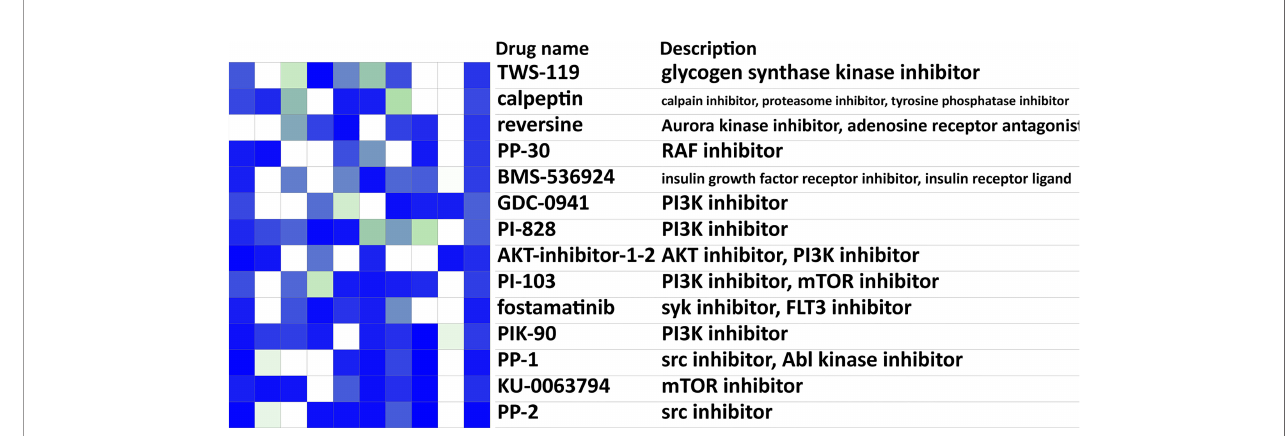
FIGURE 6 | Drug prediction analysis for targeting lung metastasis. Heatmap of the top 20 possible CMAP drugs that could reverse the breast cancer lung metastasis signature. The scores of 20 drugs ’ effects on 9 cell lines, drugs names, and their descriptions were shown. Negative scores (blue in the heatmap) indicated an ability for a given drug to reverse the breast cancer lung metastasis signature. CMAP, connectivity